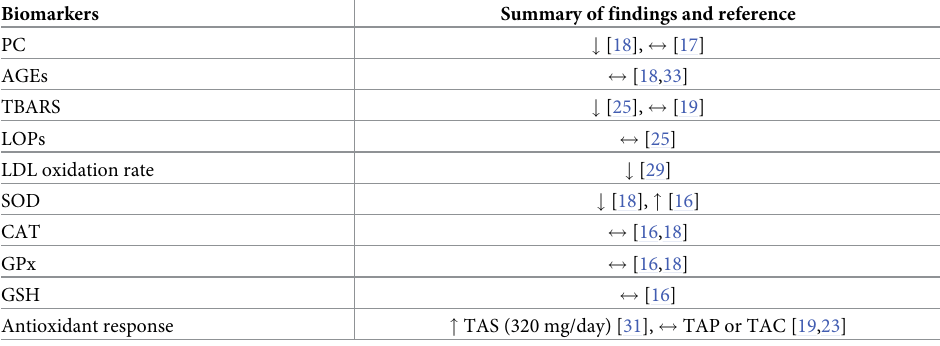
Table 4. Descriptive summary of the effects of tocotrienols supplementation on oxidative stress markers, antioxi- dant enzyme activities and antioxidant response. Biomarkers Summary of findings and